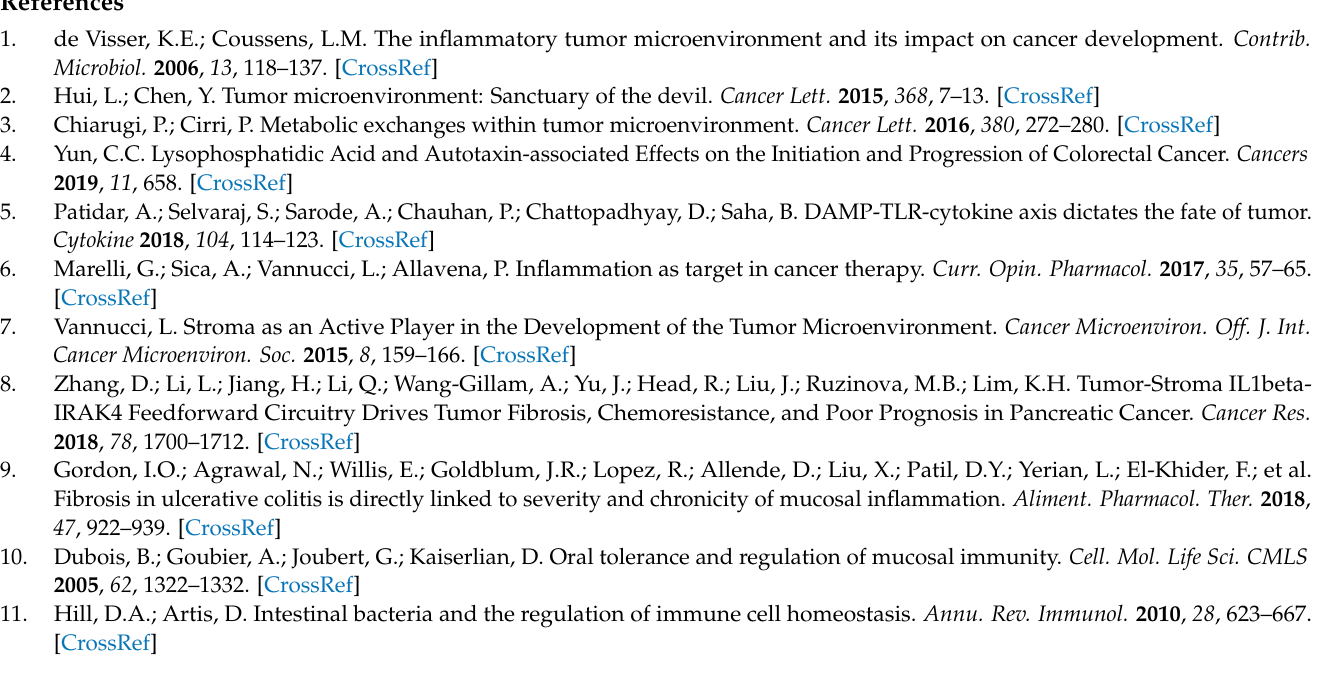
Table S1: Values of ELISA, PCR and imaging analysis statistical